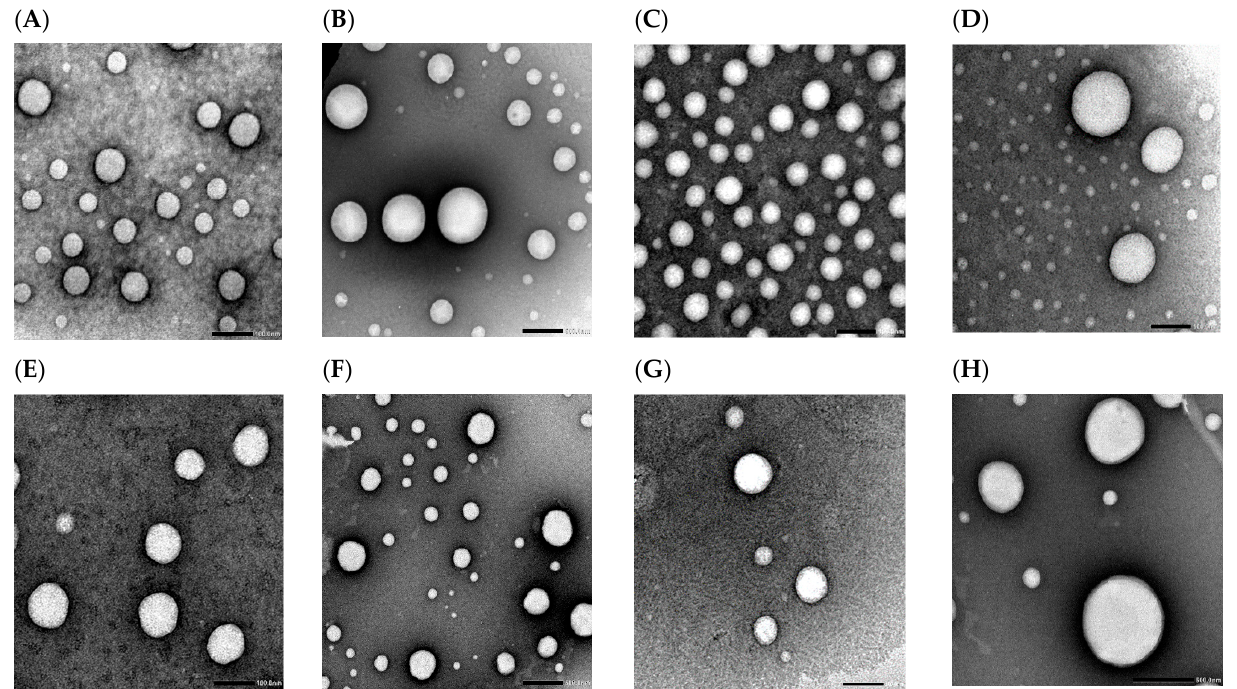
Figure 9. Transmission electron micrographs for F1 ( A , B ), F2 ( C , D ), F3 ( E , F ) and F4 ( G , H ) formulations.